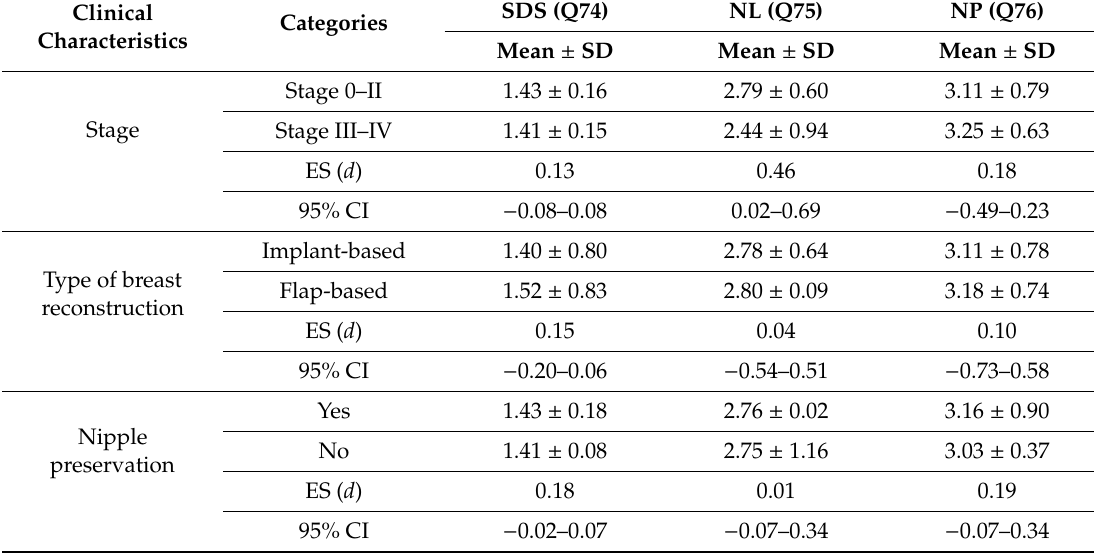
Figure 1. Factor structure of multi-item of Korean version of BRECON23. TS: Treatment side effect, SX: Sexual function with breast, SBC: Satisfaction with breast cosmetic, SNC: Satisfaction with nipple cosmetic, SSU: Satisfaction with surgery. Table 4. Known-group validity in single